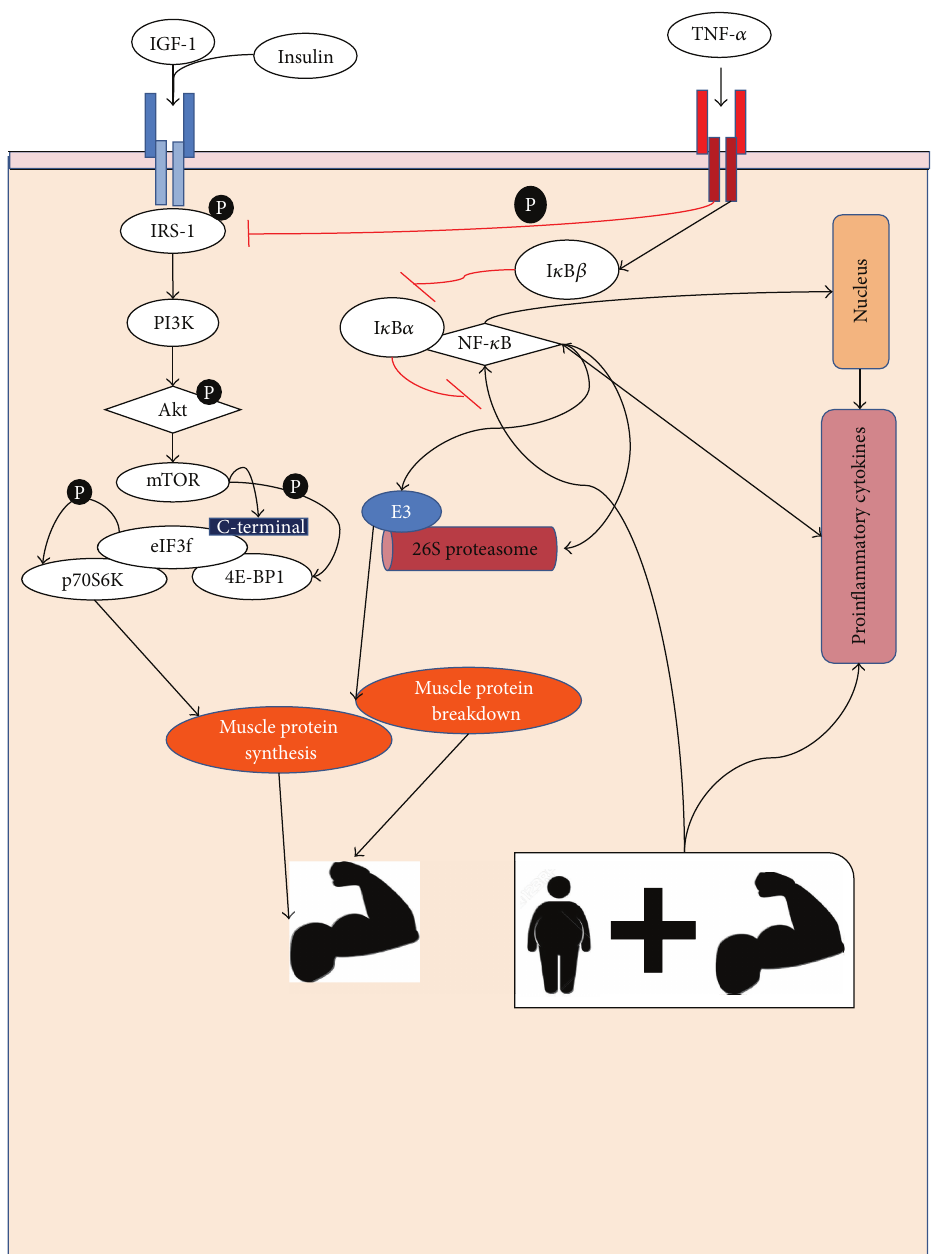
Figure 2: Influence of the inflammatory factors in the regulation of muscle